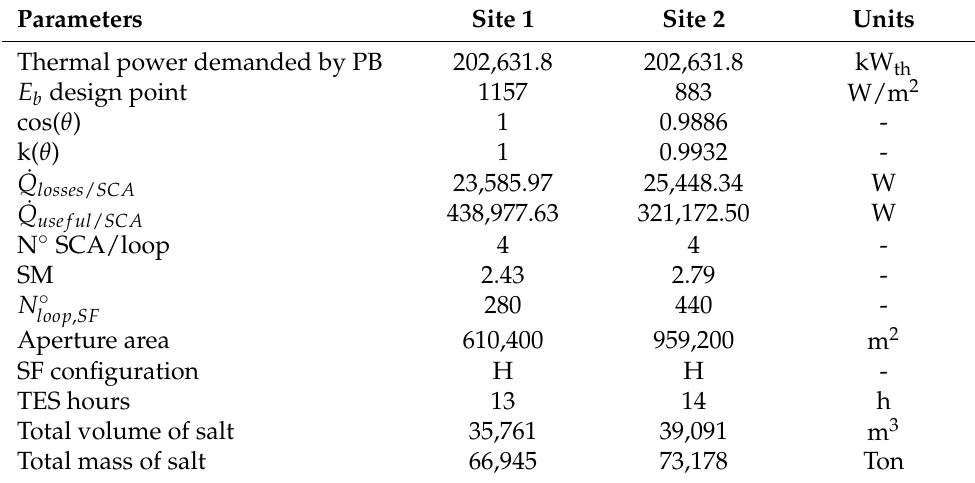
Table 7. Main parameters of each PTSTPP considered for the modeling and design